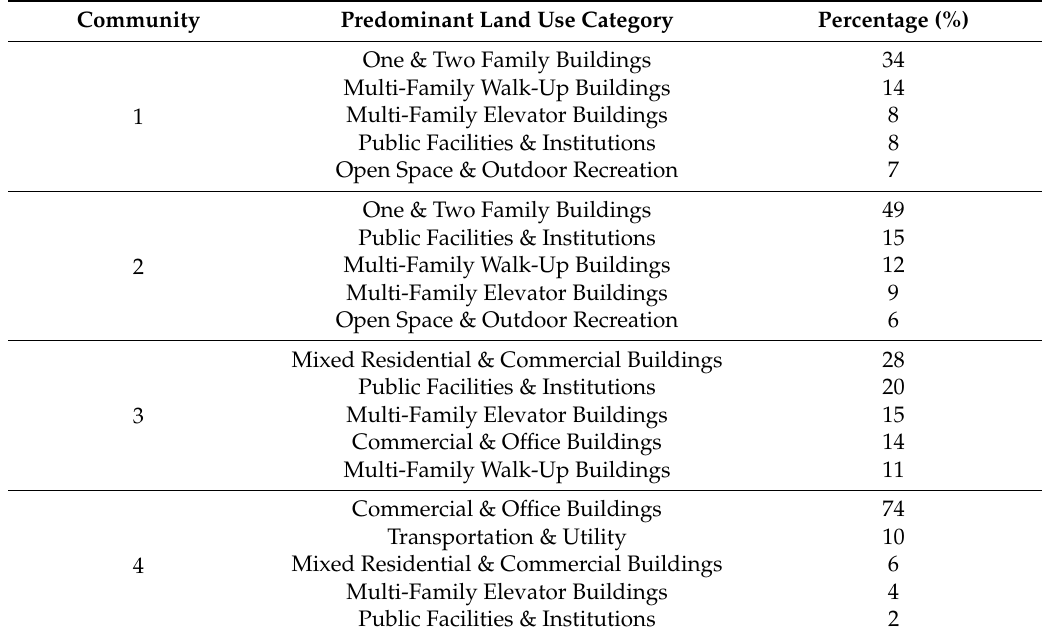
Table 3. Names and percentages of the most predominant land use categories within convex hulls of typical communities